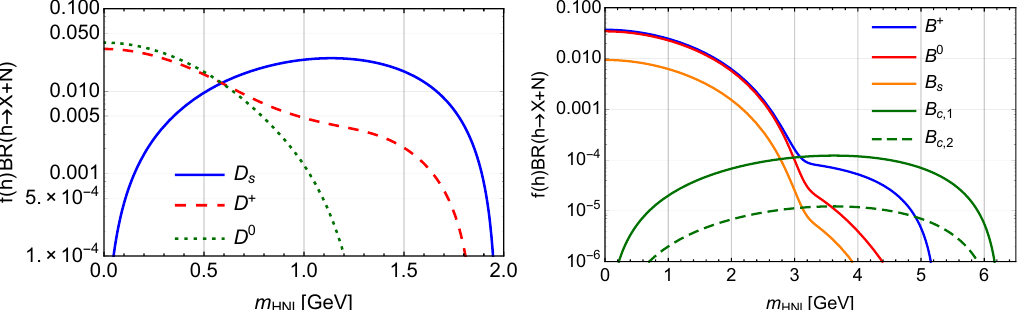
10 (cid:0) 3 ( B c; 1 line) and (cid:1)